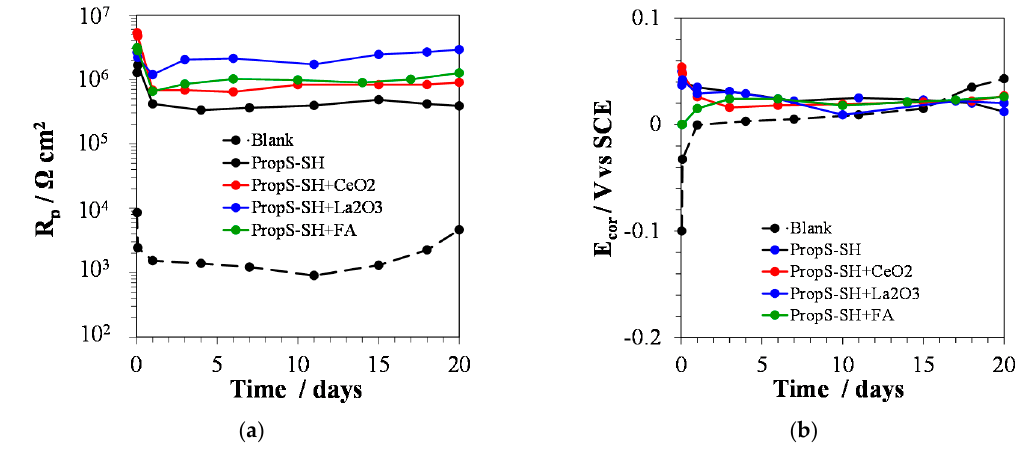
Figure 11. Evolution of polarization resistance ( R p ) ( a ) and corrosion potential ( E cor ) ( b ) values, during immersion of bare and coated bronze in AR × 10 at 30 °C. The coatings include PropS-SH and PropS-SH loaded with CeO 2 , La 2 O 3 , and FA.